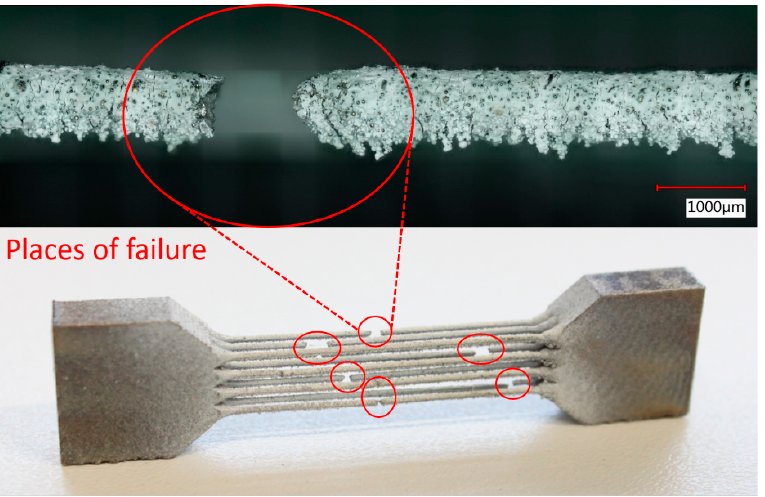
Figure 10. Multi-strut tensile sample after experiment including the detail of strut failure.